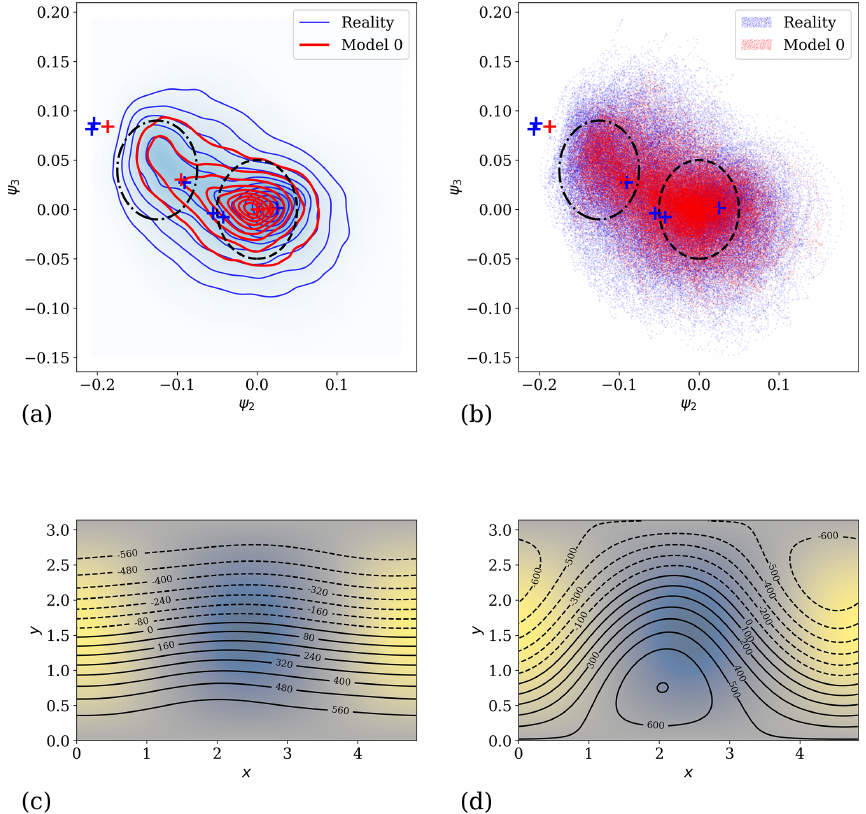
Figure 2. Attractors for the experiment with a modification of the friction coefficient: (a) two-dimensional isodensity of the attractors estimated with a Gaussian kernel density estimator for the variables ψ 2 and ψ 3 and (b) two-dimensional scatterplot of the attractors for the variables ψ 2 and ψ 3 . The attractors of reality and model 0 are qualitatively similar, with two different parts which are indicated by ellipses. The blue and red crosses correspond respectively to equilibrium points of the reference model (reality) and of model 0, respectively. The dashed ellipse corresponds on average to a zonal circulation depicted in panel (c) . The dash-dotted ellipse corresponds on average to a blocking situation depicted in panel (d) . In both panels (c) and (d) , the underlying colour map denotes the orography in the domain, and the contours denote the geopotential height anomaly at